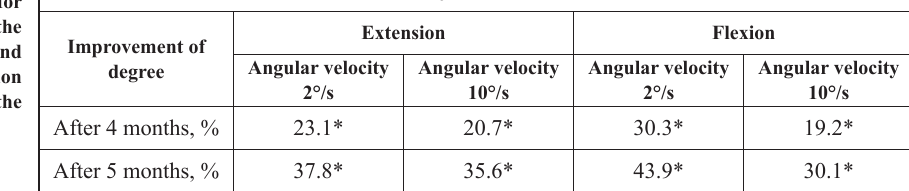
Note. * – p < 0.05; # – p < 0.001.